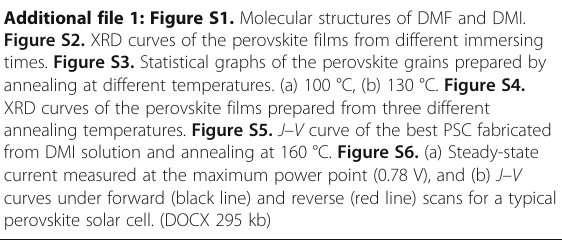
Additional file 1: Figure S1. Molecular structures of DMF and DMI. Figure S2. XRD curves of the perovskite films from different immersing times. Figure S3. Statistical graphs of the perovskite grains prepared by annealing at different temperatures. (a) 100 °C, (b) 130 °C. Figure S4. XRD curves of the perovskite films prepared from three different annealing temperatures. Figure S5. J – V curve of the best PSC fabricated from DMI solution and annealing at 160 °C. Figure S6. (a) Steady-state current measured at the maximum power point (0.78 V), and (b) J – V curves under forward (black line) and reverse (red line) scans for a typical perovskite solar cell. (DOCX 295 kb)